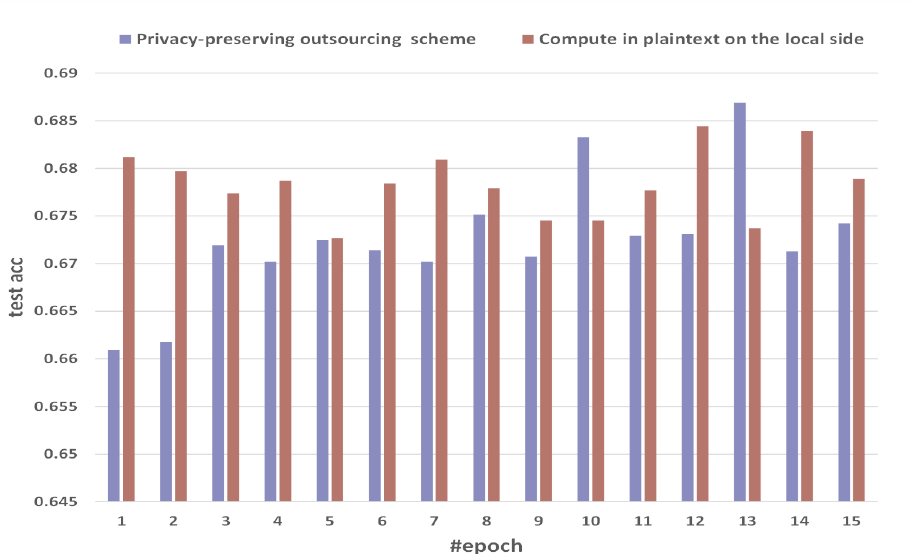
Figure 8. Comparison of test accuracy between the method of computing in plaintext on the local side and our